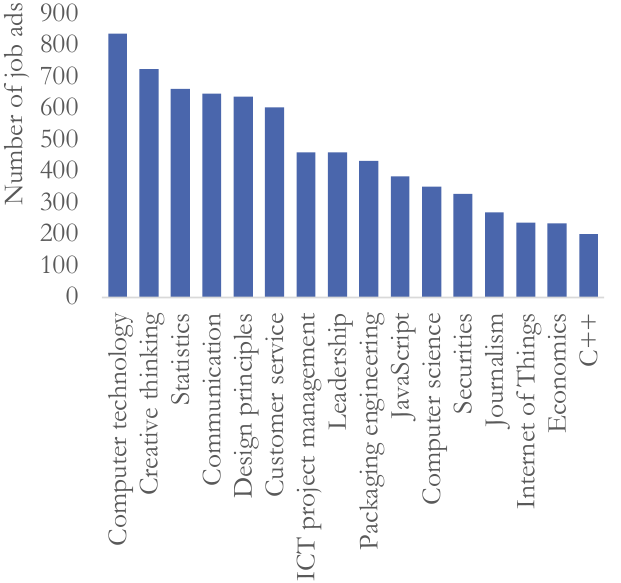
Figure 4. Top skills mentioned in Australian blockchain-related job ads between September 2015 and May 2019. Source: Data61 Australian Skills Dashboard [27]